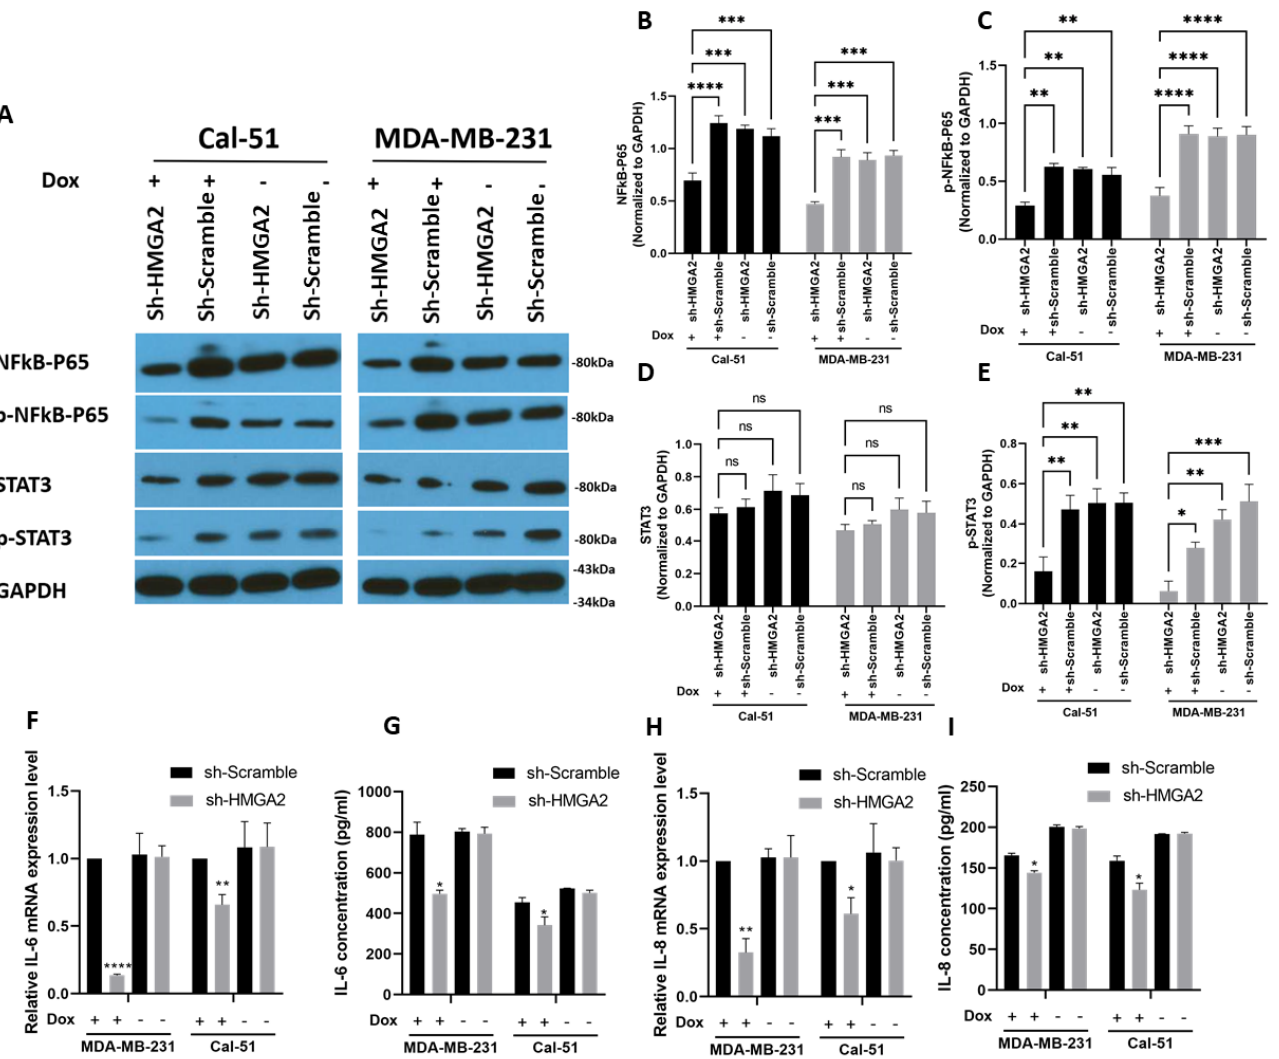
Figure 7. HMGA2 silencing decreased activation of NF-kB/IL-6/STAT3 signaling. Western blotting showed that doxycycline (Dox)-induced HMGA2 silencing (shHMGA2) decreased both NF-kB-p65 ( A , B ), p -NF-kB-p65 ( A , C ) and p-STAT3 ( A , E ) but not STAT3 ( A , D ) protein levels. In addition, HMGA2 silencing decreased IL-6 ( F , G ) and IL-8 ( H , I ) in both the mRNA and protein levels ( n = 3). * p < 0.05, ** p < 0.01, *** p < 0.001, and **** p < 0.0001 by t -test versus the shScramble group.